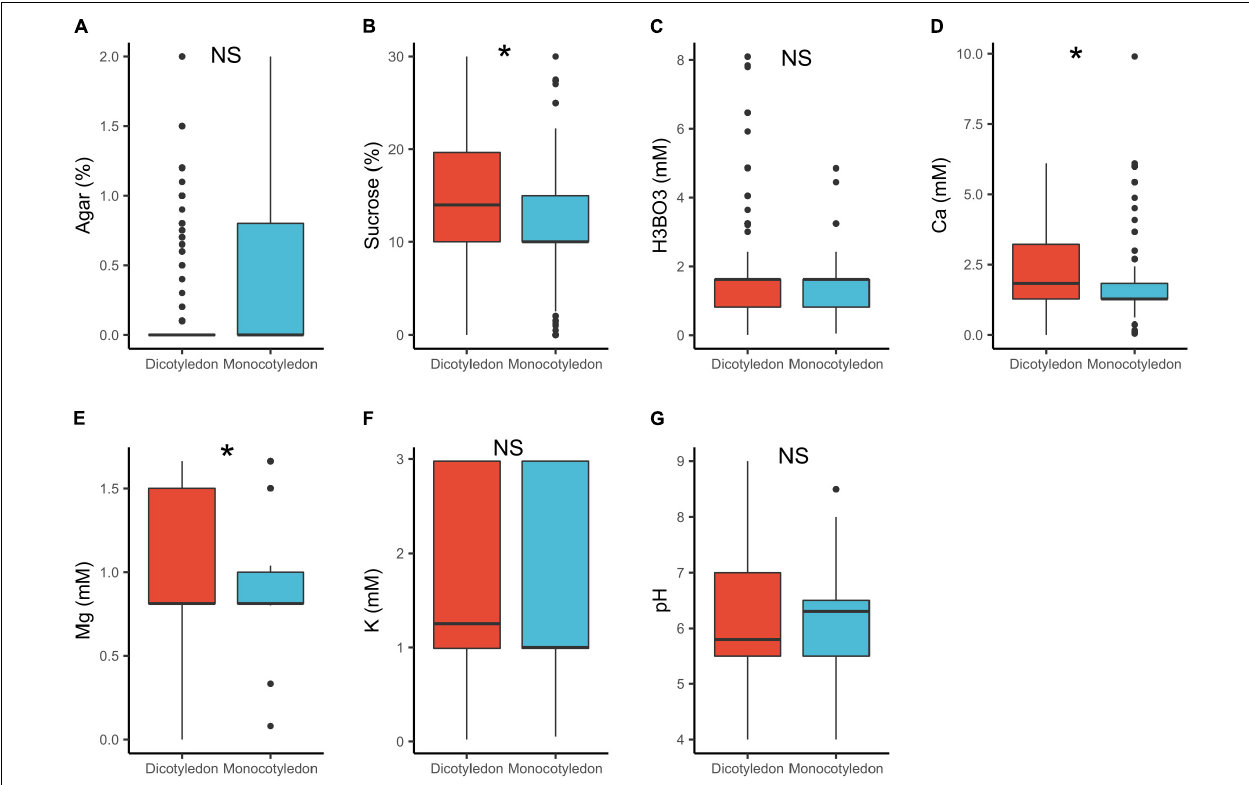
FIGURE 3 | Pollen germination media requirements for dicotyledons ( n = 818) and monocotyledons ( n = 274): agar (A) , sucrose (B) , boric acid (C) , calcium (D) , magnesium (E) , potassium (F) , and pH (G) . *, significant ( p < 0.05); NS, not significant.